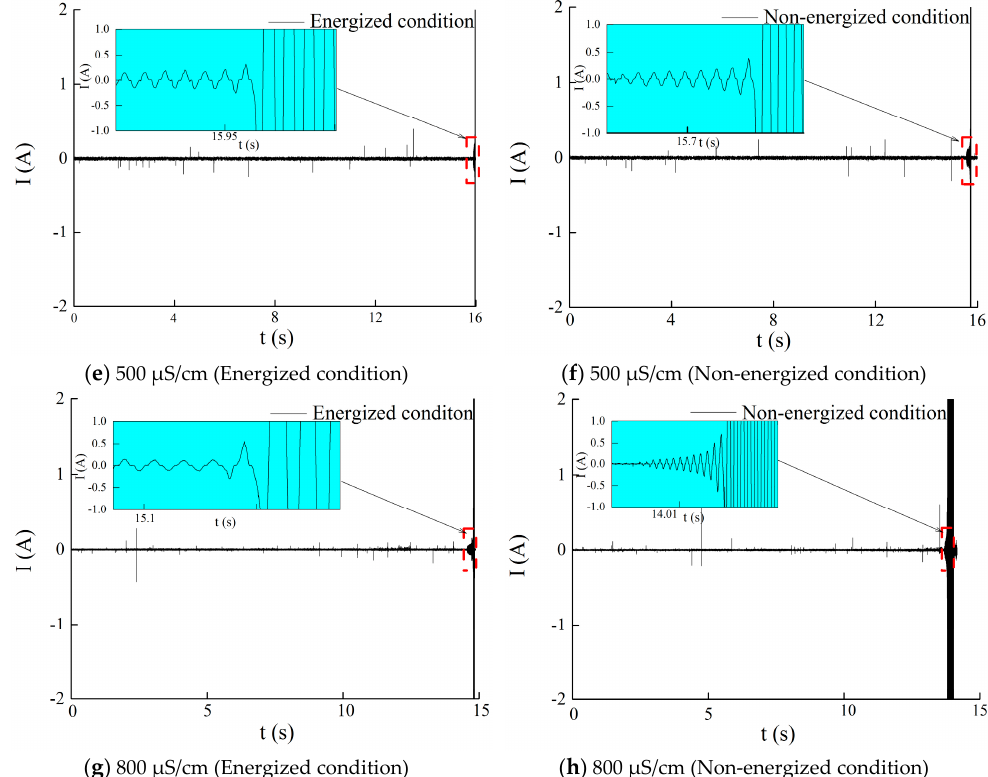
Figure 11. Wave forms of leakage current during the flashover process.